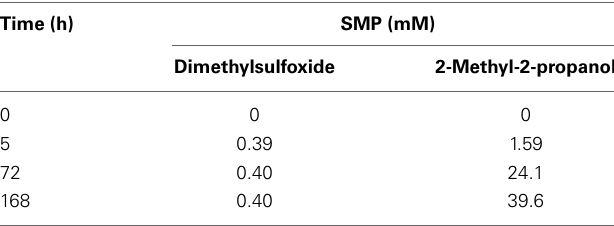
Table 3 | Effect of the solvent used on the production of sucrose 6 (cid:2) -monopalmitate (SMP) a